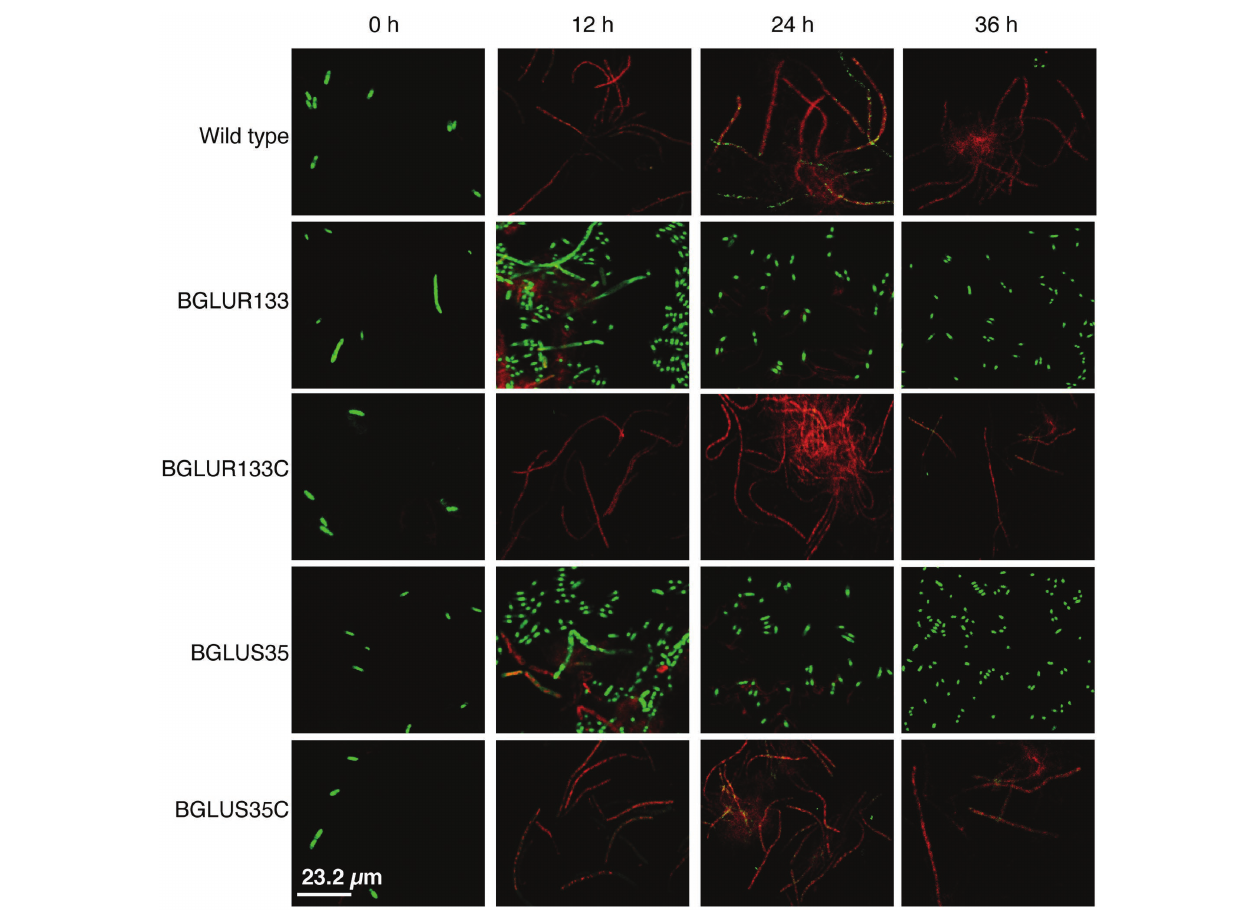
FIGURE 2 | The gluS and gluR mutants maintained viability in a carbenicillin environment. Cell viability of the WT, TCS mutants (BGLUS35 and BGLUR133), and their respective mutant complemented strains (BGLUS35C and BGLUR133C) cultured in LB medium with 50 μ g/ml carbenicillin was assessed by combination staining with propidium iodide (PI) and SYTO 9 green at the indicated times. Fluorescence images were obtained at excitation/emission wavelengths of 483/490– 540 and 535/890–680 nm for green (live cells) and red (dead cells) fluorescence, respectively.